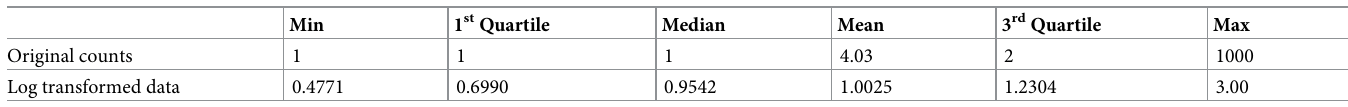
Table 8. Summary descriptive statistics for cluster 2 for detection data from Barrow Island between 2009 and